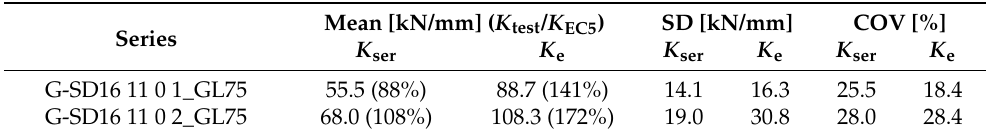
Table 6. Initial stiffness K ser and reloading stiffness K e from tensile tests on steel-timber dowel-type connections using beech LVL, Ø = 16 mm [33,34].